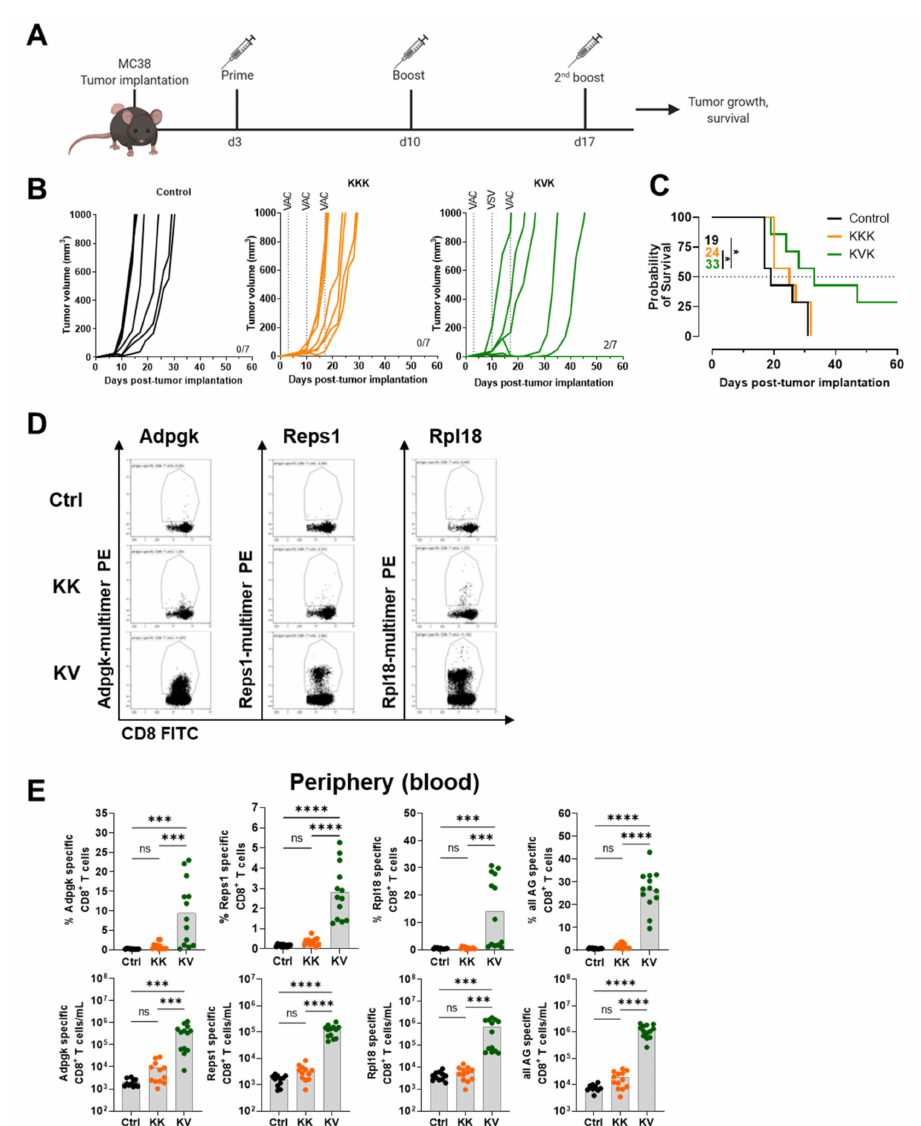
Figure 3. Improved efficacy and increase in multiple antigen-specific CD8+ T cells in the periphery of heterologous prime-boost-treated MC-38 tumor-bearing C57BL/6 mice. ( A ) Treatment schedule of prime (KISIMA-Mad46 s.c.), boost (VSV-GP-Mad46 i.v. or KISIMA-Mad46 s.c.) an d 2nd boost (KISIMA-Mad46 s.c.) vaccination after MC-38 tumor implantation in female C57BL/6 mice for monitoring tumor-growth and prolonged overall survival. ( B ) Individual tumor-growth curves in mm 3 post-tumor implantation for untreated controls, KKK or KVK-treated female C57BL/6 mice. ( C ) Kaplan–Meier survival graphs of MC-38 tumor-bearing female C57BL/6 mice (n = 7 per group). ( D ) Representative FACS dot plots of blood-derived Adpgk, Reps1 and Rpl18-specific CD8+ T cells. From left to right: Control, KK or KV treatment group is shown on day 18 post-MC-38 tumor implantatio ( E ) From left to right: % (upper part) or absolute numbers (lower part) of blood-derived Adpgk-, Reps1-, Rpl18- or all three (sum) antigen-specific CD8+ T cells sampled on day 16 or 17 post-MC-38 tumor implantation. Data in ( D , E ) are shown as means (grey bar) and derived from two independent experiments. * p < 0.05, *** p < 0.001, **** p < 0.0001 One-Way ANOVA followed by Tukey’s multiple comparison test. Data shown in ( B , C ) are derived from one experiment (n = 7). * p < 0.05 Mantel-Cox Log-rank